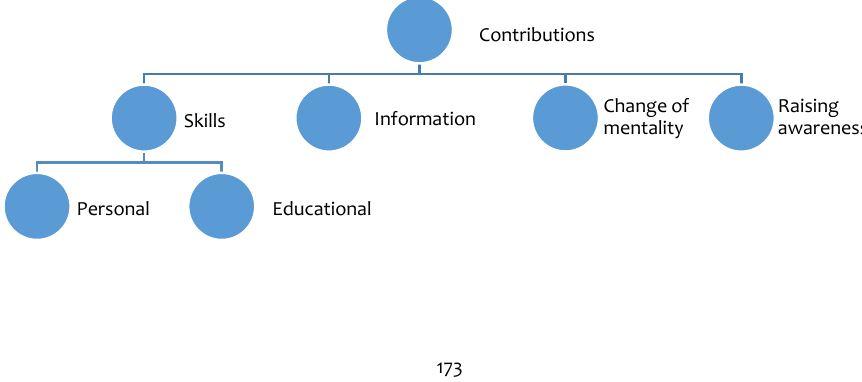
Figure 4. The Contributions of the Museum Education Course to the Prospective